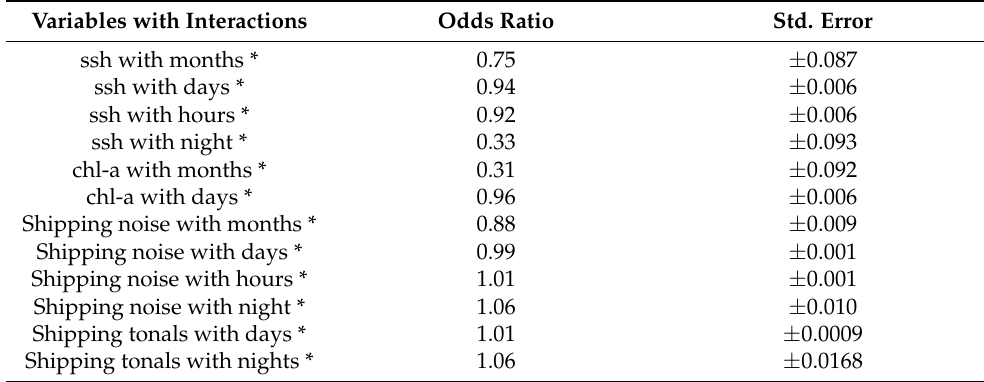
Table 5. Results of the logistic regression with significant interaction terms between explanatory variables for fin whale